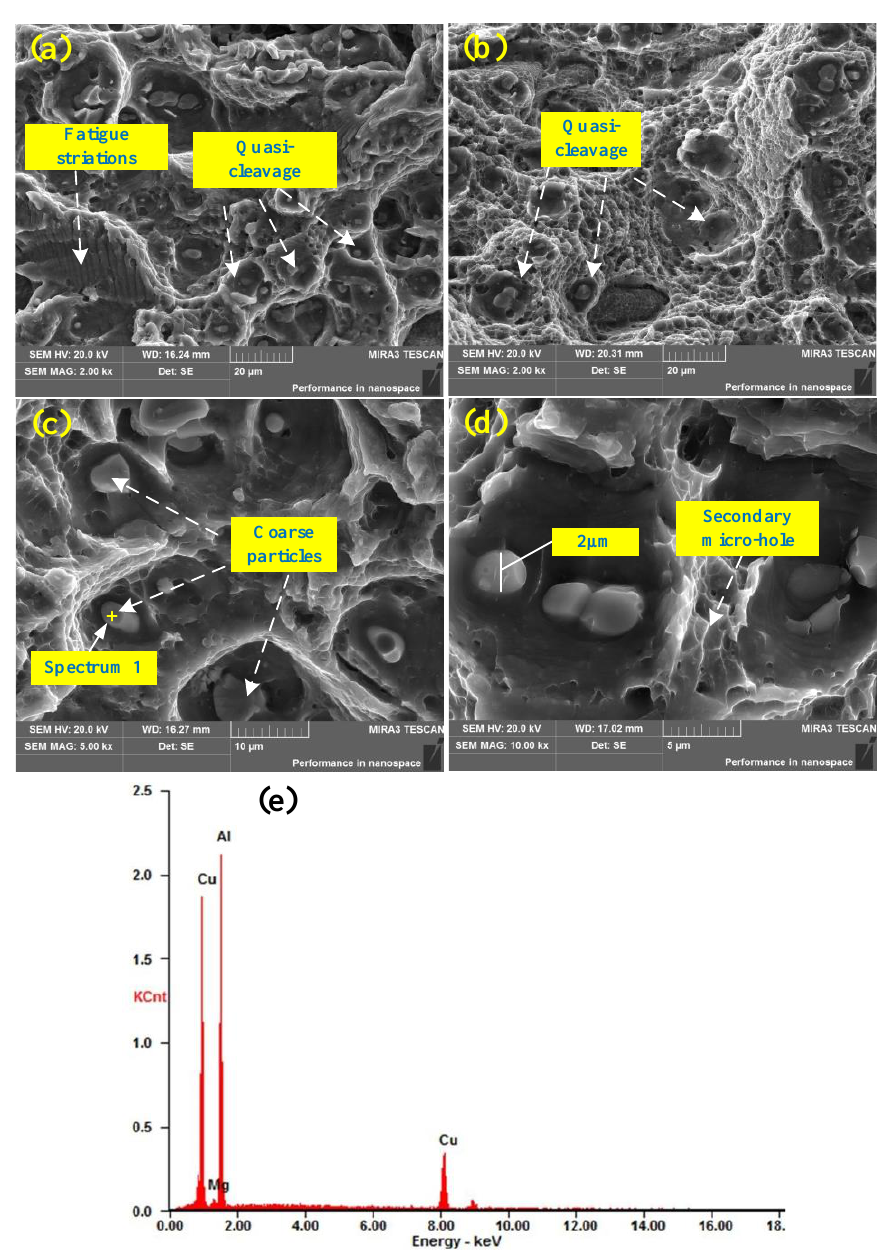
Figure 11. Microscopic morphology of the fatigue rapid growth zone: ( a ) crack propagation and fracture transition zone; ( b ) instantaneous failure zone; ( c , d ) enlarged views of dimples, ( e ) EDX map of the coarse particles.